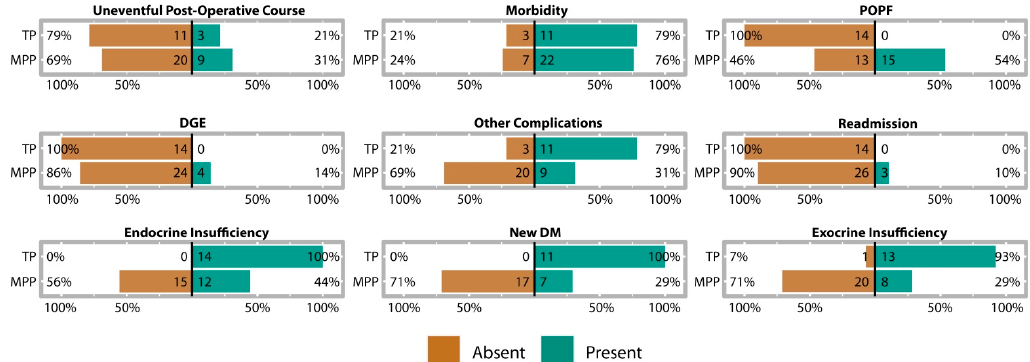
Figure 4. Within-group proportions for the presence or absence of postoperative complications during hospital stays. Frequency counts are provided within the bars. DGE: delayed gastric emptying. DM: diabetes mellitus. POPF: postoperative pancreatic fistula.